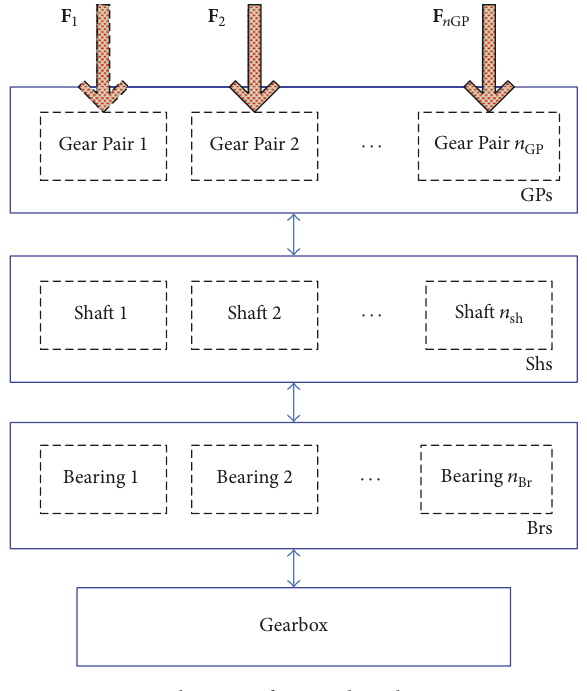
Figure 1: Schematic of a typical gearbox structure.